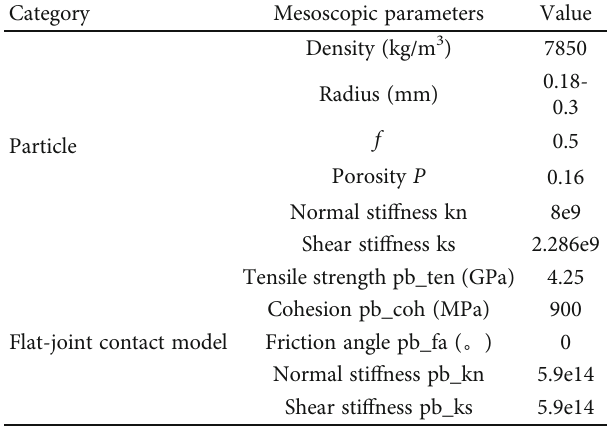
Table 2: Mesoscopic parameters of bolt.